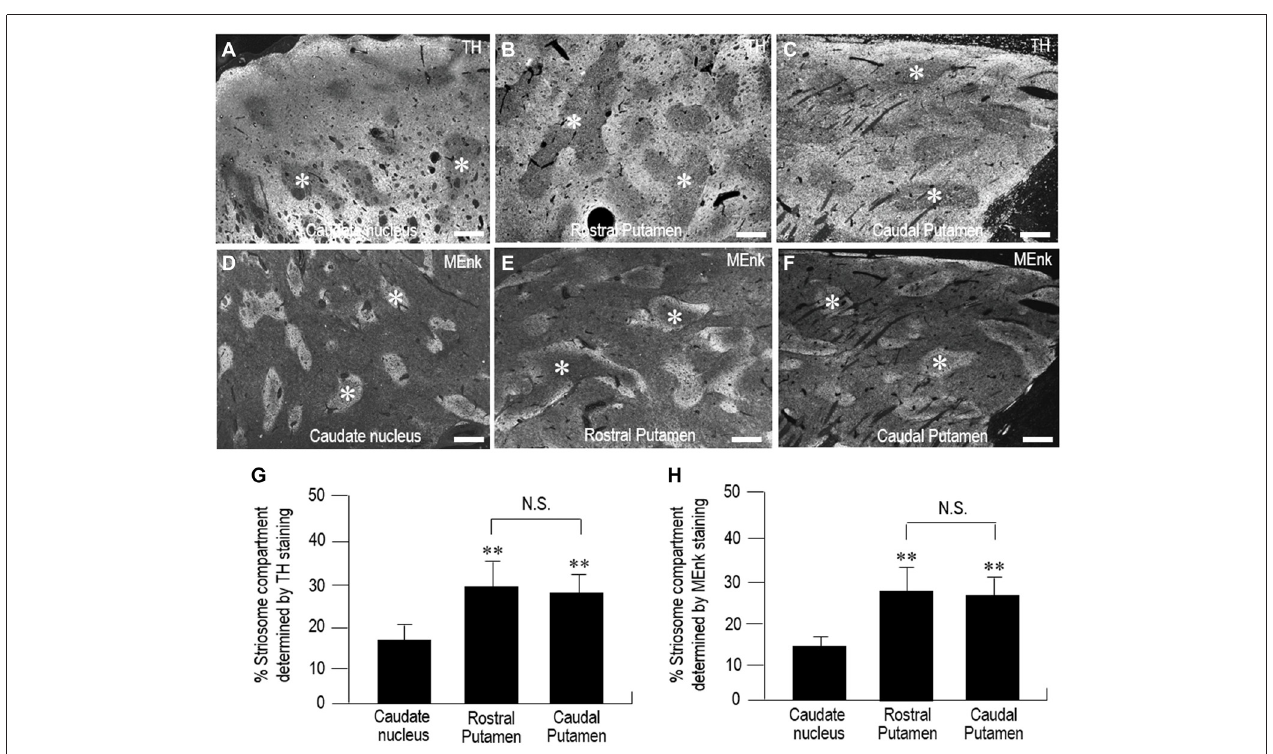
FIGURE 8 | Morphometric analysis of the percentage of the striatum occupied by the striosome compartment in the human neostriatum. (A–F) Gray-scale-converted microscopic images of striatal areas stained with fluorescence for TH (A–C) and MEnk (D–F) in the CN (A,D) , rostral putamen (B,E) , and caudal putamen (C,F) . Asterisks indicate examples of striosomes. Scale bars: 1 mm. (G) Measurements of the percentage of the striatum occupied by the striosome compartment identified by TH-immunostaining in the CN, rostral putamen, and caudal putamen. Data represent means ± SEM (bars), n = 25. ∗∗ indicates P < 0.01 vs. CN; N.S. (not significant) indicates P > 0.05, Rostral Putamen vs. Caudal Putamen. (H) Measurements of the percentage of the striatum occupied by the striosome compartment identified by MEnk-immunostaining in the CN, rostral putamen, and caudal putamen. Data represent means ± SEM (bars), n = 25. ∗∗ indicates P < 0.01 vs. CN; N.S. (not significant) indicates P > 0.05, Rostral Putamen vs. Caudal